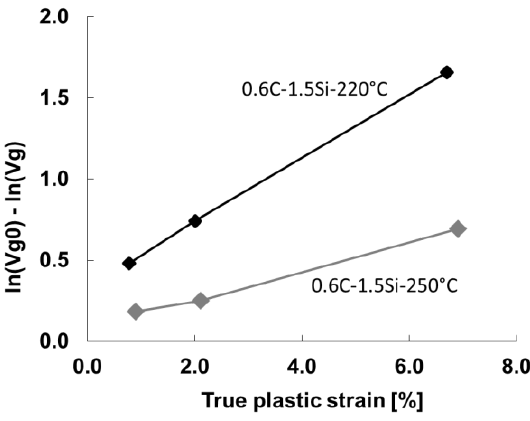
Figure 9. Evolution of the content of transformed retained austenite for the same steel subjected to different heat treatments: bainitic treatment at 220 °C or at 250 °C. The slope of the lines is K , the fitting parameter of Equation 3. Adapted from references [53,66].